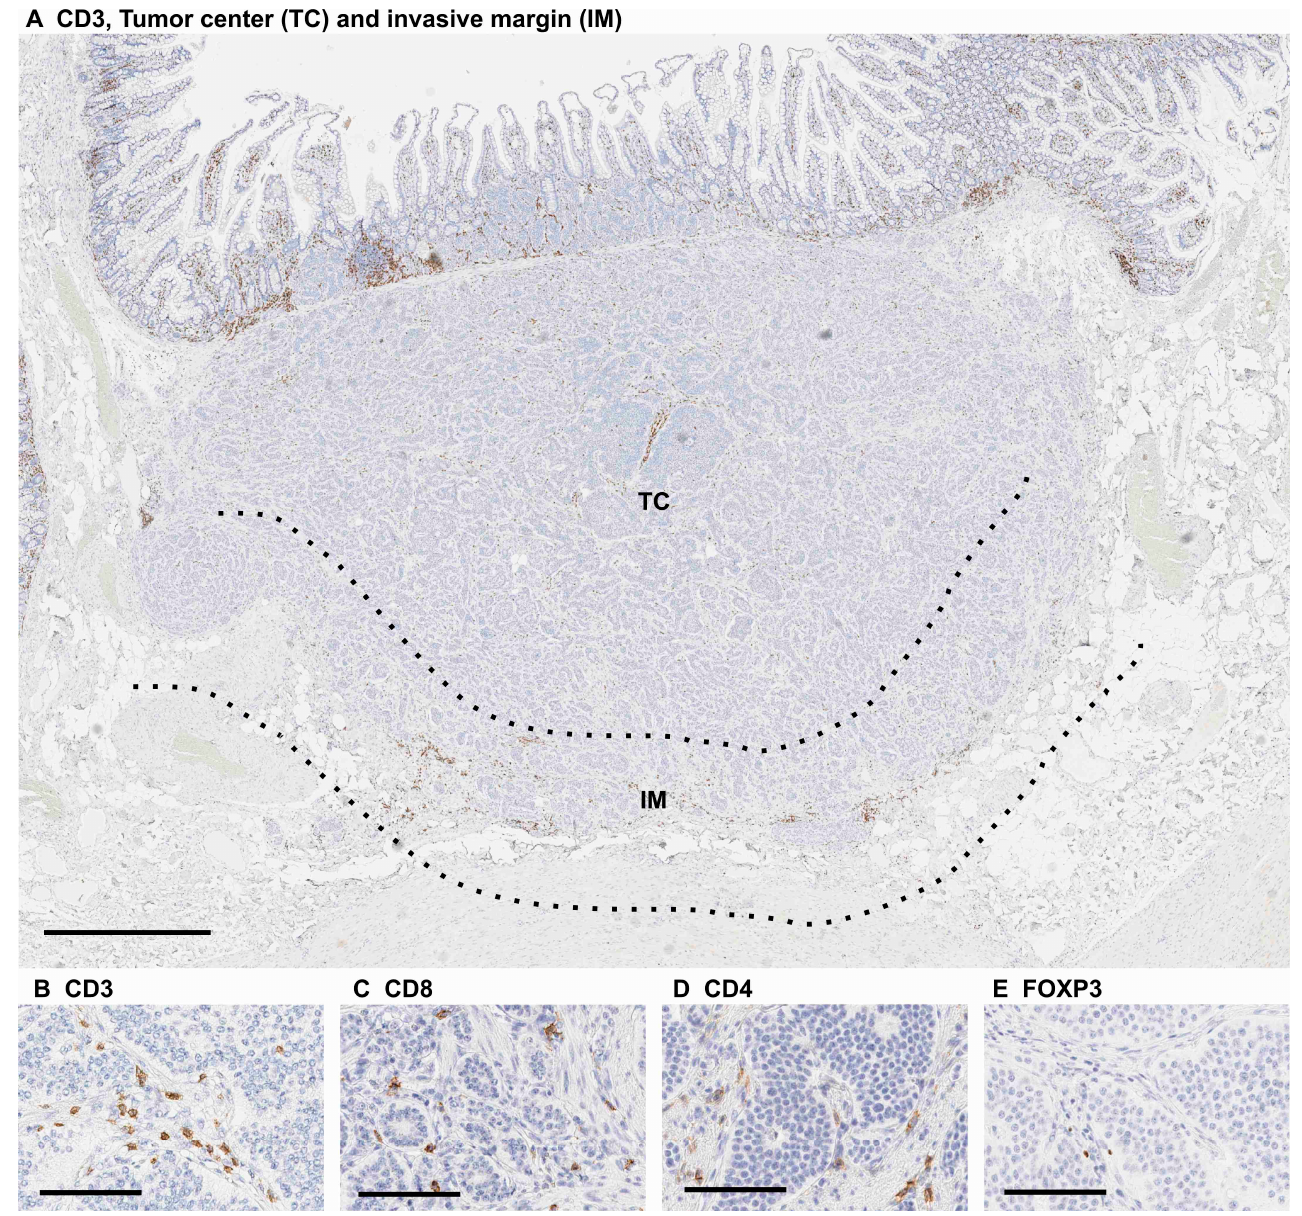
Figure 2. ( A ) CD3 + immunohistochemistry in small bowel neuroendocrine tumor tissue showing the tumor center (TC) and the invasive margin (IM) used to determine immune cell score: ( B – E ) Examples of CD3 + , CD8 + , CD4 + and FOXP3 + T cell infiltrations in immunohistochemical stainings. Scale bars are 1 mm ( A ) and 100 µm ( B – E ).